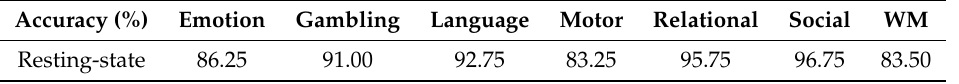
Table A6. The prediction accuracy of the classifier based on the linear-dimensional (PCA)